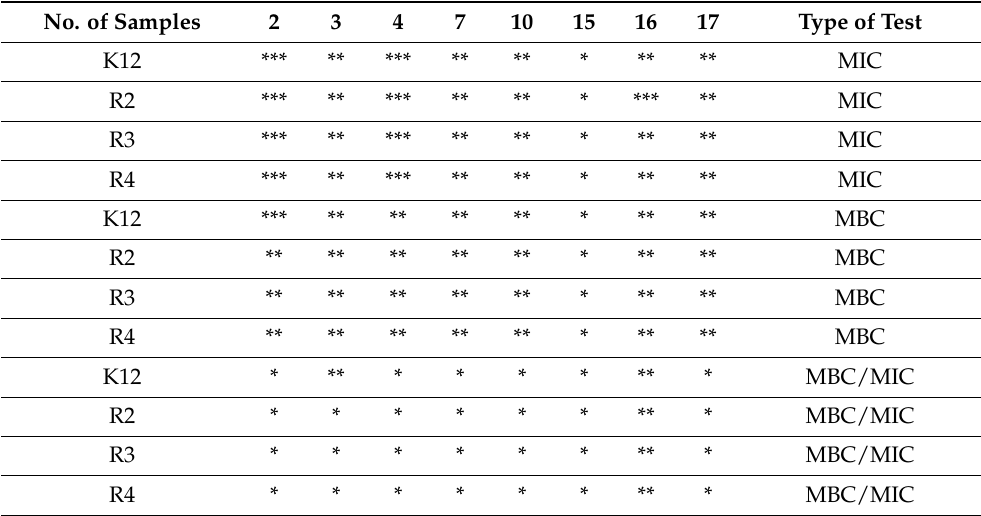
Table 2. Statistical analysis of all analyzed compounds by MIC, MBC, and MBC/MIC; <0.05 *, <0.01 **, <0.001